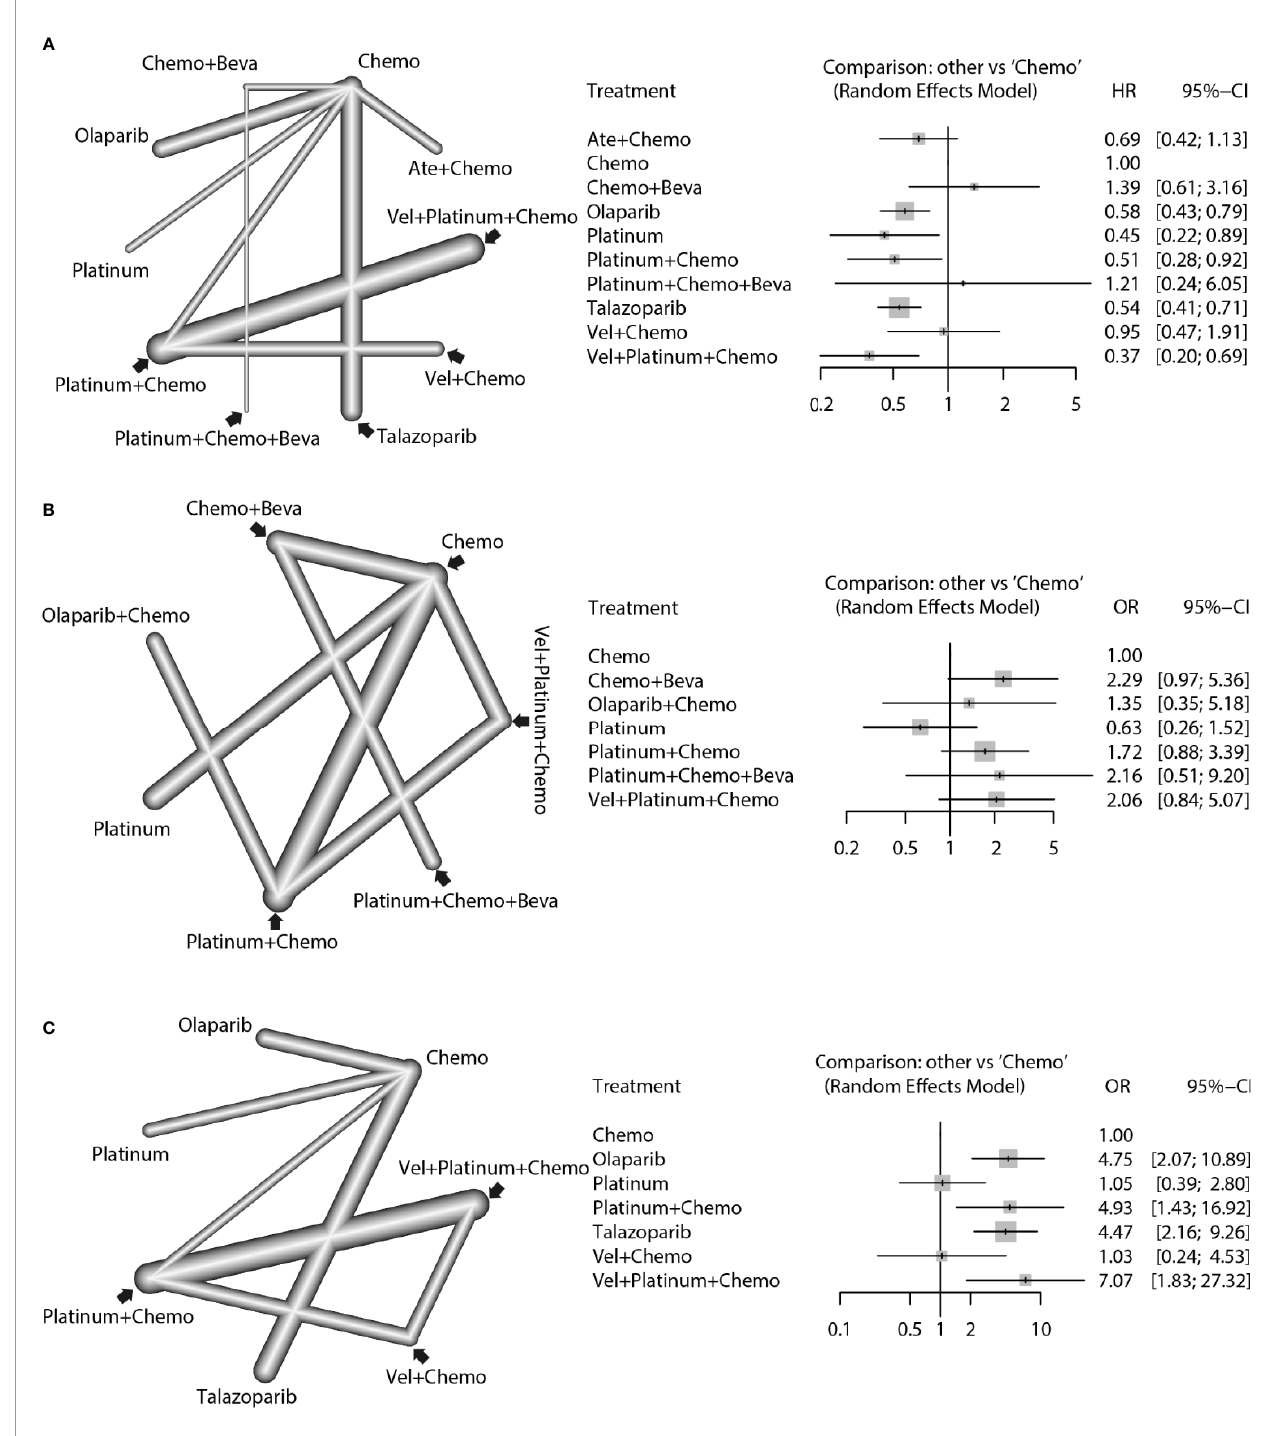
FIGURE 3 | Network comparisons of PFS (A) , pCR (B) , and ORR (C) results for the strategies included in the analyses. The left side of the fi gure shows the network diagrams. Each dot indicates an intervention, and the edge between the two dots indicates that there is a direct comparison from the RCT. The thickness of the edge represents the precision of the comparisons. On the right, forest plots show the network meta-analysis results for all comparisons between Chemo and other